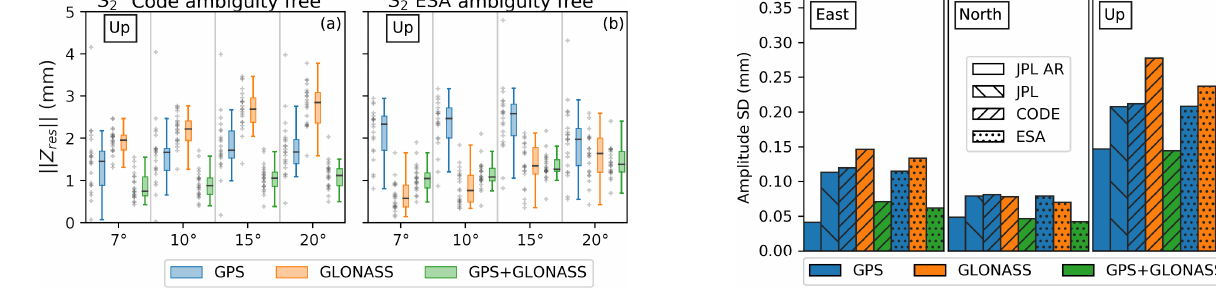
Figure 6. GPS, GLONASS and GPS+GLONASS (cid:107) Z res (cid:107) for the S 2 constituent in the up component as a function of elevation cutoff angle, computed with ESA (a) and CODE products (b) . Note the inverse behaviour of GPS and GLONASS biases and the linear de- pendence of the GLONASS biases. Grey crosses are as per Fig. 3.